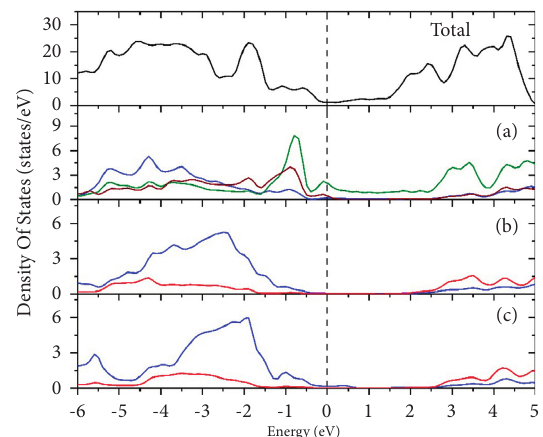
Figure 8: DOS and PDOS for the Ge-terminated surface: (a), (b), and (c) exhibit the PDOS for the 1 st , 2 nd , and 3 rd GaN bilayers, respectively. The red lines correspond to Ga-p, the blue lines are the contributions of N-p, and Ge-p is represented as olive lines.